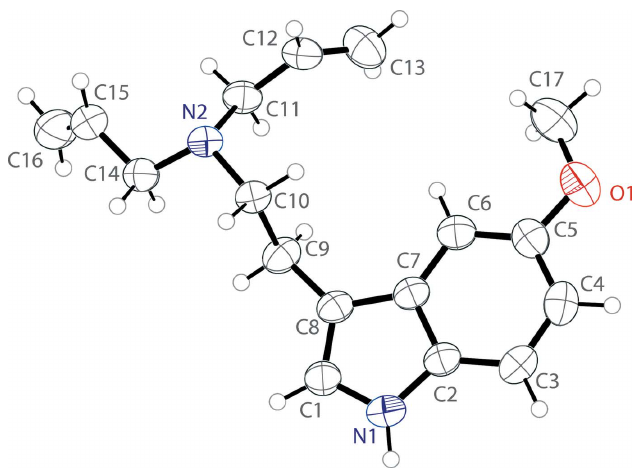
Figure 1 The molecular structure of 5-methoxy- N , N -diallyltryptamine, showing the atom labeling. Displacement ellipsoids are drawn at the 50% probability